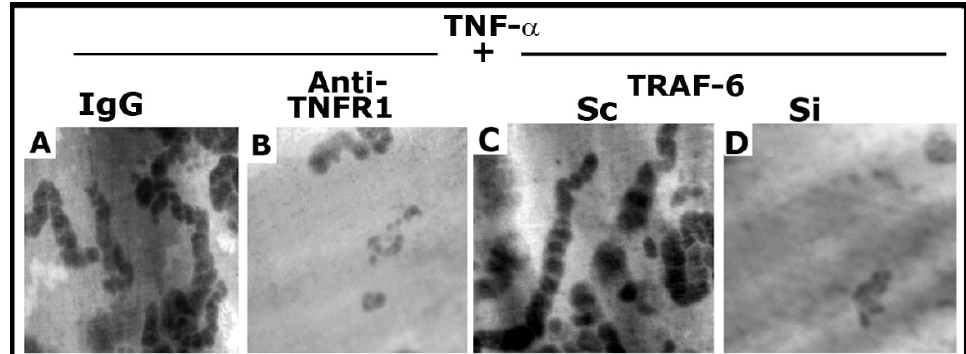
Figure 7. The effect of anti-TNFR1 and TRAF-6 SiRNA on osteoclast bone resorption in vitro. Resorption pits were seen as dark spots. Resorption pits were viewed under a 40× objective in a phase-contrast microscope and photographed. The magnification was ×400. For each treatment, three to four dentine slices were used per experiment. Experiments were repeated two times with two different osteoclast preparations, and similar results were obtained. Treatments were as follows: IgG: Species-specific IgG control for Anti-TNFR1 ( A ); Anti-TNFR1: antibody to TNFR1-treated osteoclasts ( B ); Scrambled RNAi (Sc)-treated osteoclasts ( C ); Si: SiRNA of TRAF-6 treated osteoclasts ( D ).